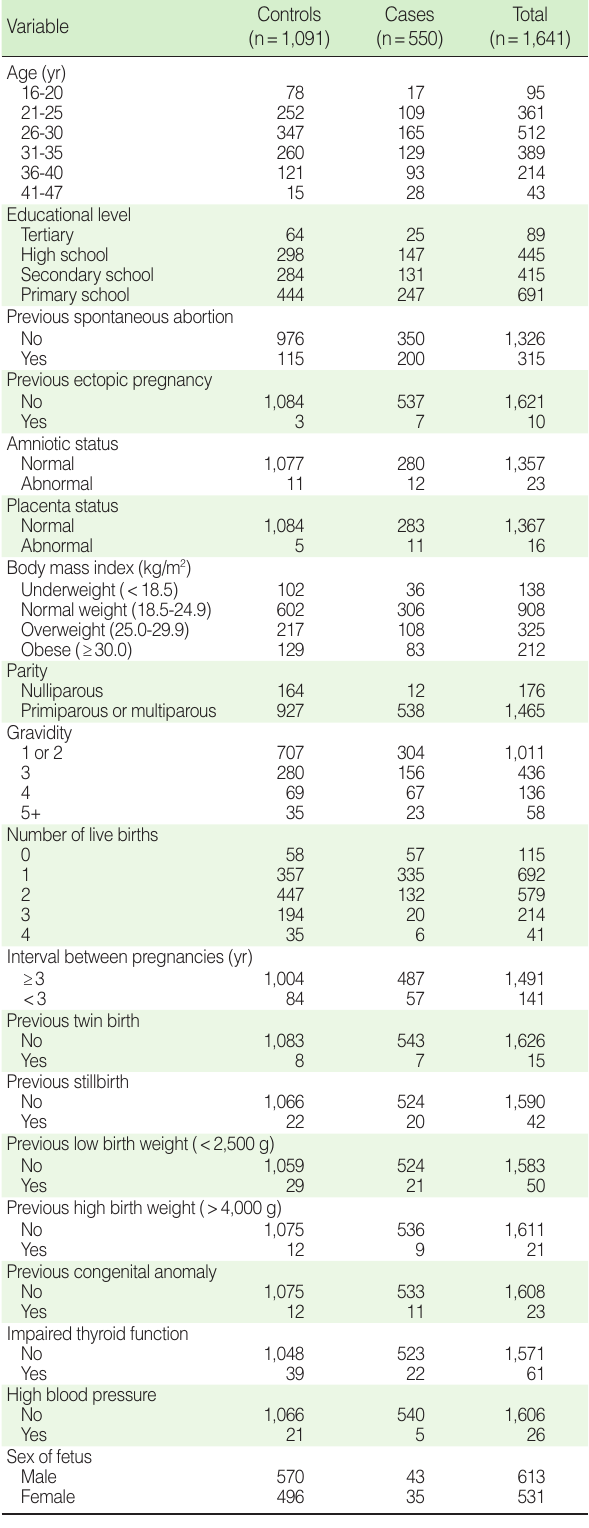
Table 1. Characteristics of the study